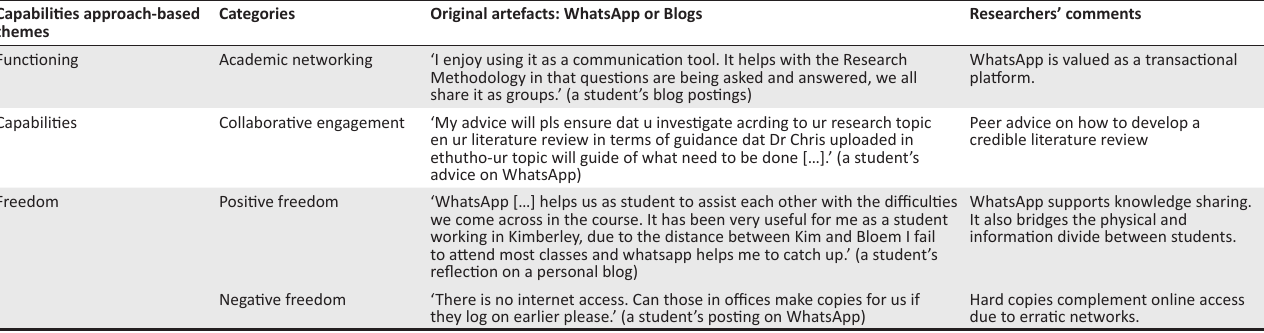
TABLE 1: An analysis of original WhatsApp and Blog posts using Sen’s capabilities approach. Capabilities approach-based